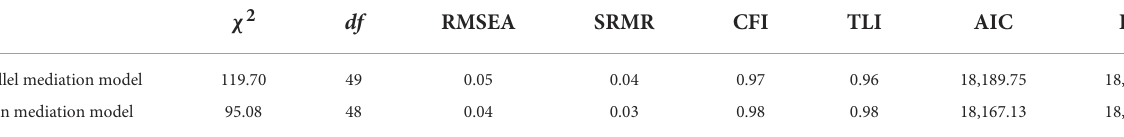
TABLE 2 Parallel and chain mediation model fitting